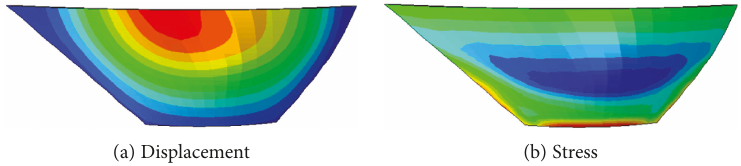
Figure 17: Displacement and stress distribution of arch dam under gravity and hydrostatic pressure.